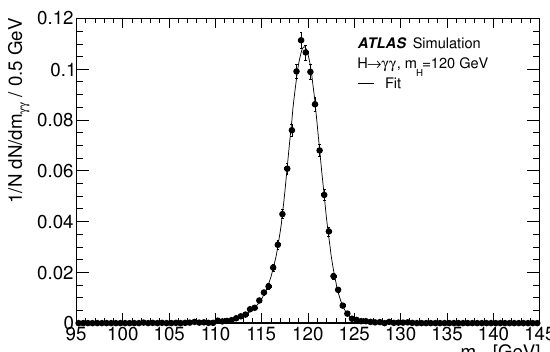
Fig. 4. The observed and expected 95% confidence level limits, normalized to the SM Higgs boson cross sections, as a function of the Higgs boson